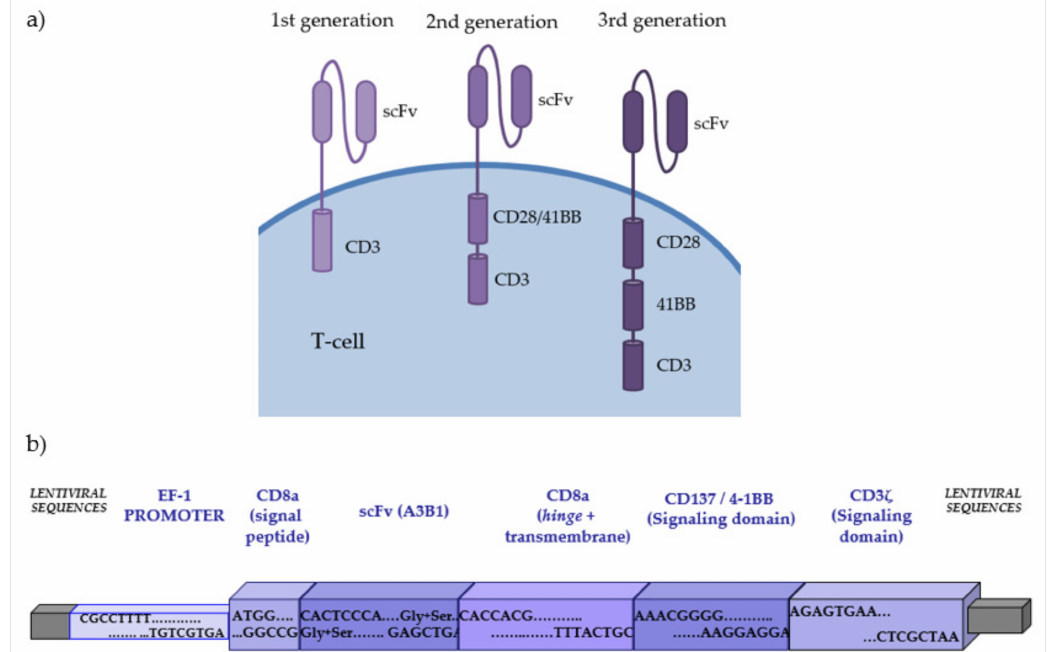
Figure 1. ( a ) Different generations of CAR-T cells. First-generation CAR-T cells include an intracellular domain. Second- generation CAR-T cells incorporate an additional co-stimulatory domain. Third-generation CAR-T cells include multiple co-stimulatory domains. ( b ) Structure of second-generation anti-CD19 CAR developed at the Immunology Department of Hospital Cl í nic de